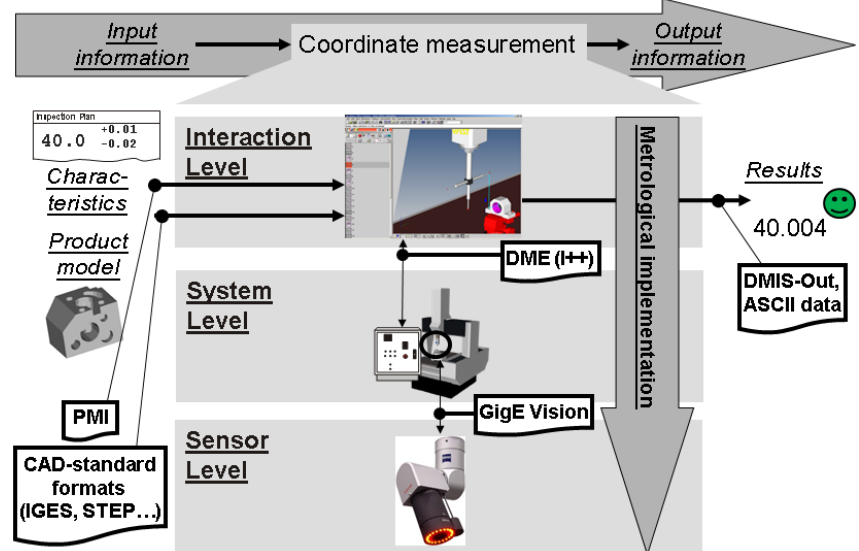
Figure 10. Levels of information technology connections (interfaces) in a coordinate measuring machine with camera sensor (PMI – product and manufacturing information, DME I ++ – dimensional measurement equipment